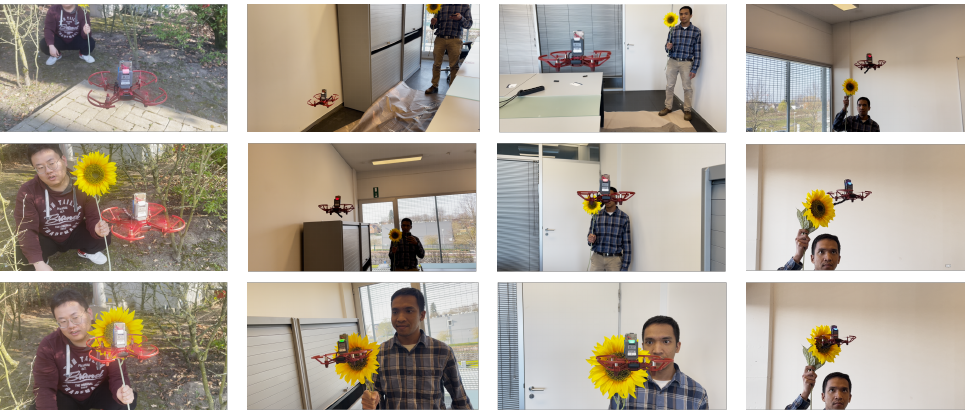
Figure 16. (Columnwise) Successful navigation trials towards the pollination